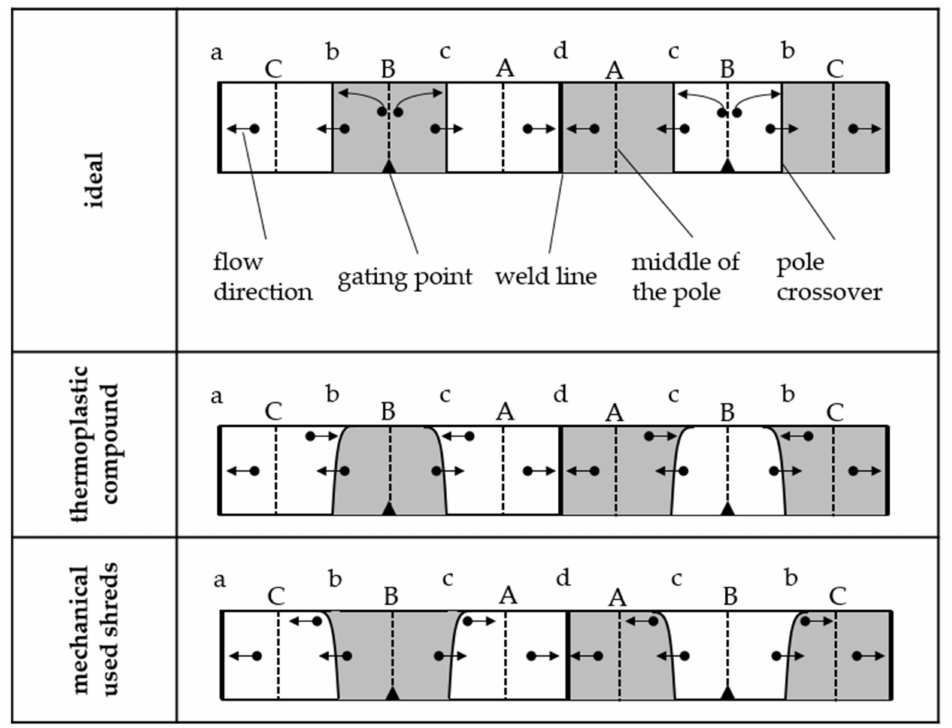
Figure 15. Change of the pole width relative to the flow direction and the gating point for thermo- plastic compound and mechanically used shreds [A/B/C: characteristic poles and middle of the poles; a/b/c/d: pole